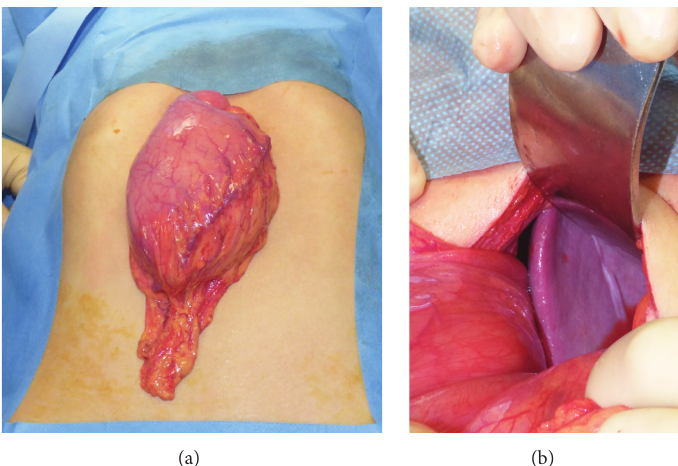
Figure 4: Intraoperative findings: the stomach is rotated with the displacement of the cardia under the pyloric level (a); moreover, the spleen is rotated medially and displaced in the left flank